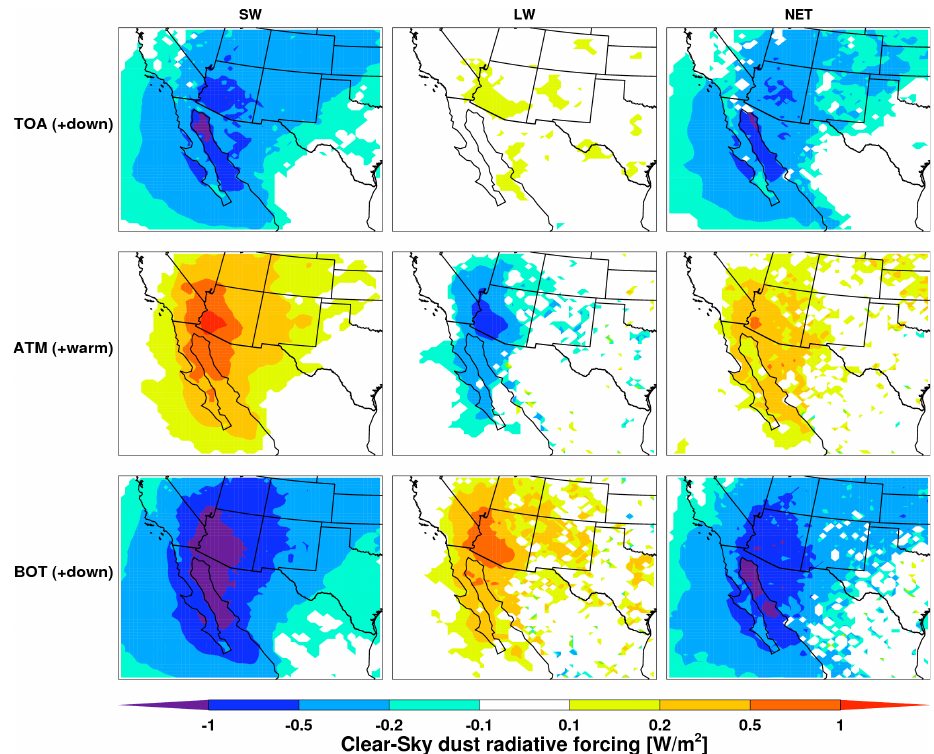
Fig. 5. Averaged clear-sky SW and LW radiative forcing of dust over the NAM region from WRF-Chem simulations. “TOA (+down)” Figure 5 Averaged clear-sky SW and LW radiative forcing of dust over the NAM region 5 represents the dust radiative forcing at the top of atmosphere and positive refers to downward direction; “ATM (+warm)” represents the dust radiative forcing in the atmosphere and positive refers to warming effect; “BOT (+down)” represents the dust radiative forcing at the surface and positive refers to downward direction. “Net” represents the sum of dust SW and LW radiative